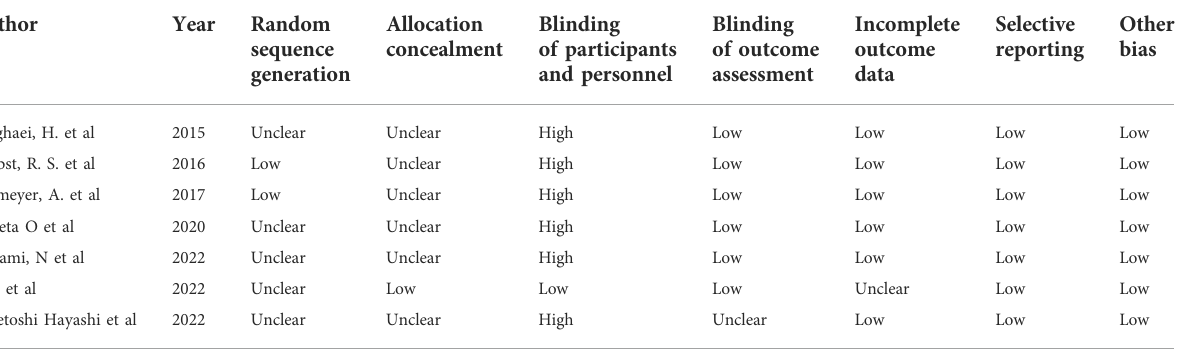
TABLE 4 Risk of bias of included randomized controlled